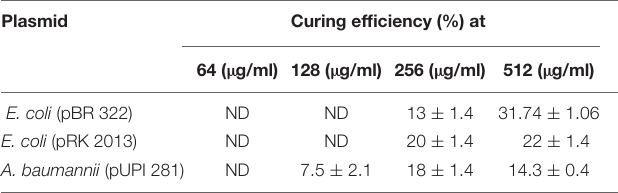
TABLE 6 | Effect of concentration of lawsone on curing efficiency. Plasmid